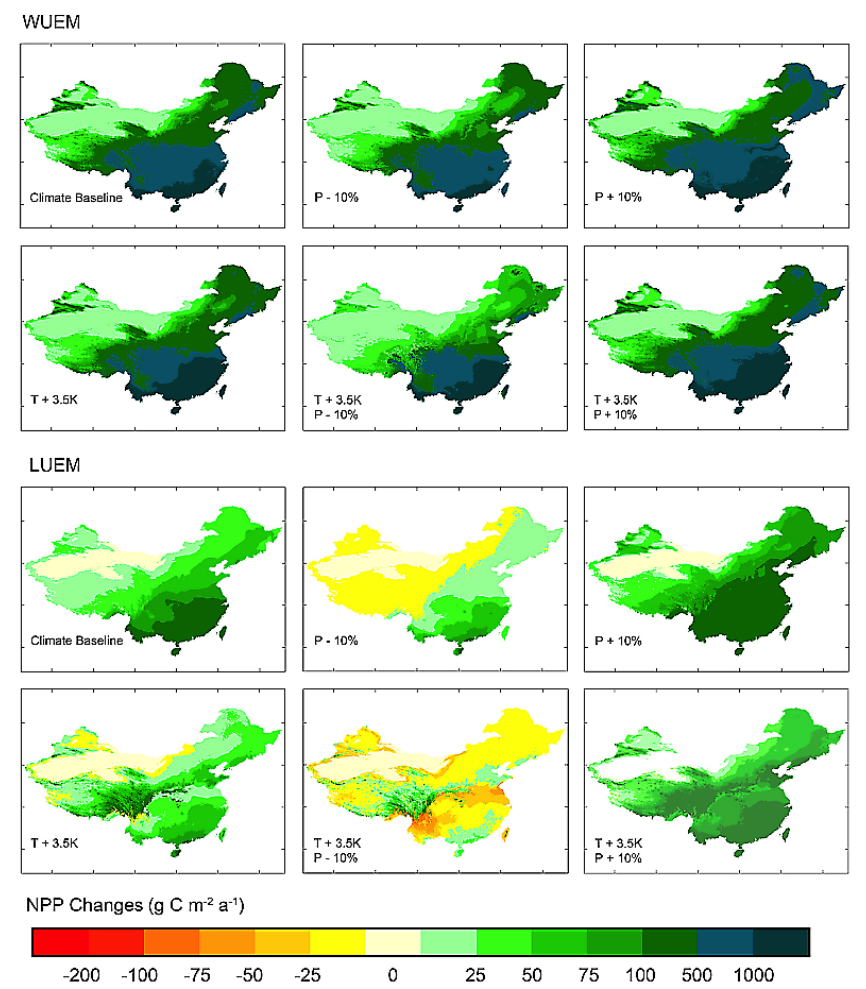
Fig. 5. The distribution pattern of NPP changes predicted by WUE model and LUE model, in six climatic scenarios under doubled [CO 2